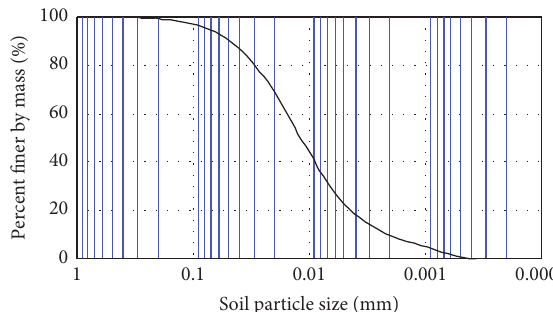
Figure 1: Particle analysis curve of Qinghai-Tibet silty Table 1: Physical properties of Qinghai-Tibet silty clay.